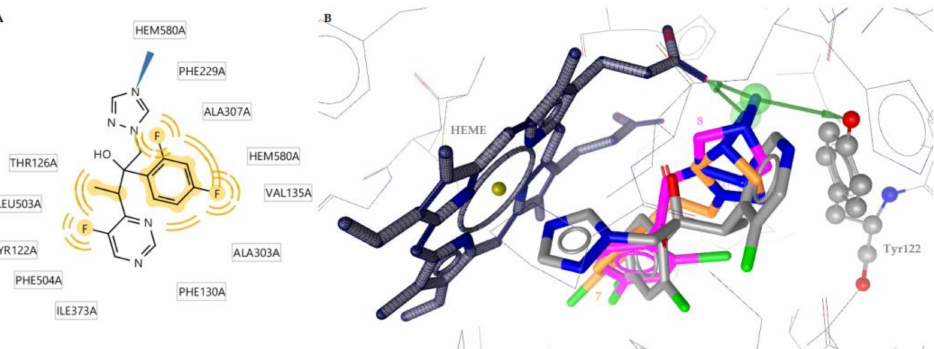
Figure 7. ( A ) 2D diagram of the syncrystalized drug voriconazole in 14-alpha demethylase (CYP51B) from the fungus Aspergillus fumigatus . ( B ) Superposition of most active compounds 8 (magenta), 7 (orange), and voriconazole (grey) 14-alpha demethylase (CYP51B) from the fungus Aspergillus fumiga- tus . Green arrows indicate a hydrogen bond; yellow spheres indicate the hydrophobic interactions, and the blue line indicates